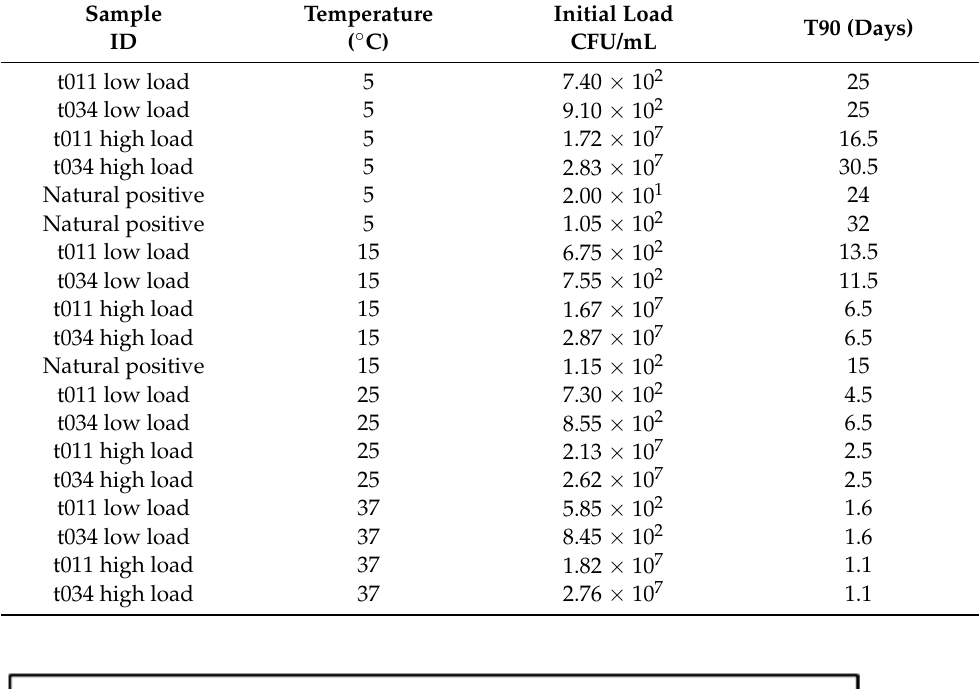
Table 1. Overview of T90 at different temperatures and initial livestock-associated methicillin- resistant Staphylococcus aureus (LA-MRSA) loads.